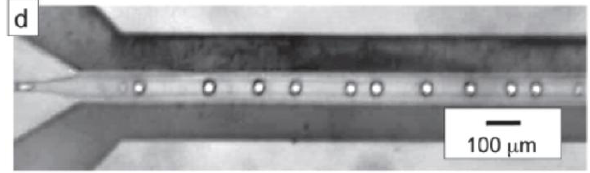
Figure 28. Picture of the device where the dark regions are the metal lines and the gray region in the middle is the channel. Reprinted with permission from [64]. Copyright 2009, Royal Society of